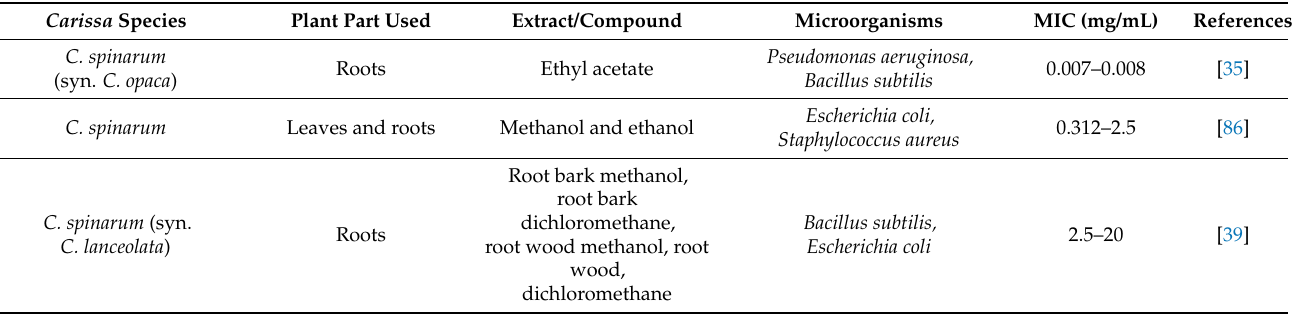
Table 4. Antimicrobial potential of Carissa